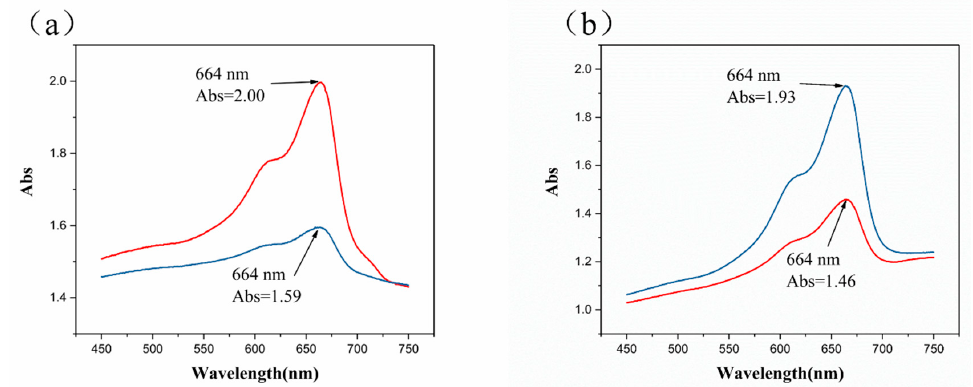
Figure 6. UV absorption spectra of blue bottle solution (before and after UV irradiation for 30 s) for ( a ) sample T2 and ( b ) sample T4.